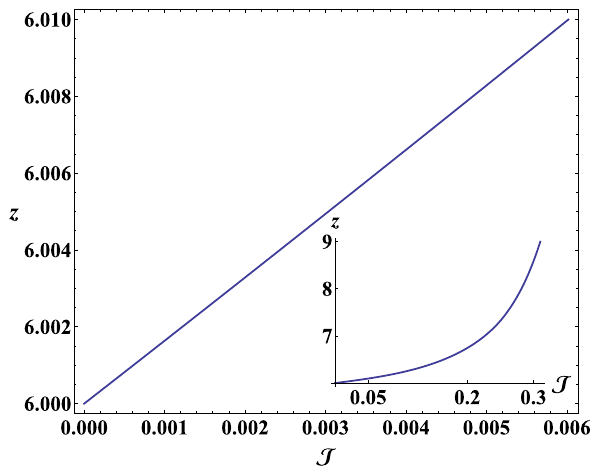
Fig. 1 Radius of the innermost stable circular orbit for non-zero spin contribution from the total energy (5). We plot the dimensionless dis- tance z = r / r 0 as a function of normalized spin J = J /( mr 0 ) . We focus in the J (cid:6) 1